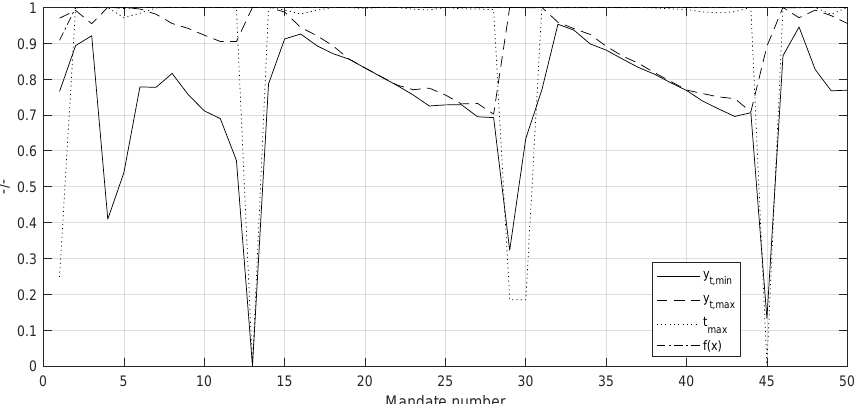
Figure 9. Tax policy long run evolution under yardstick vote during ten mandates for welfare spending efficiency η wf = 0.1 and tax incentive ξ = 0.3. Total of 50 four year